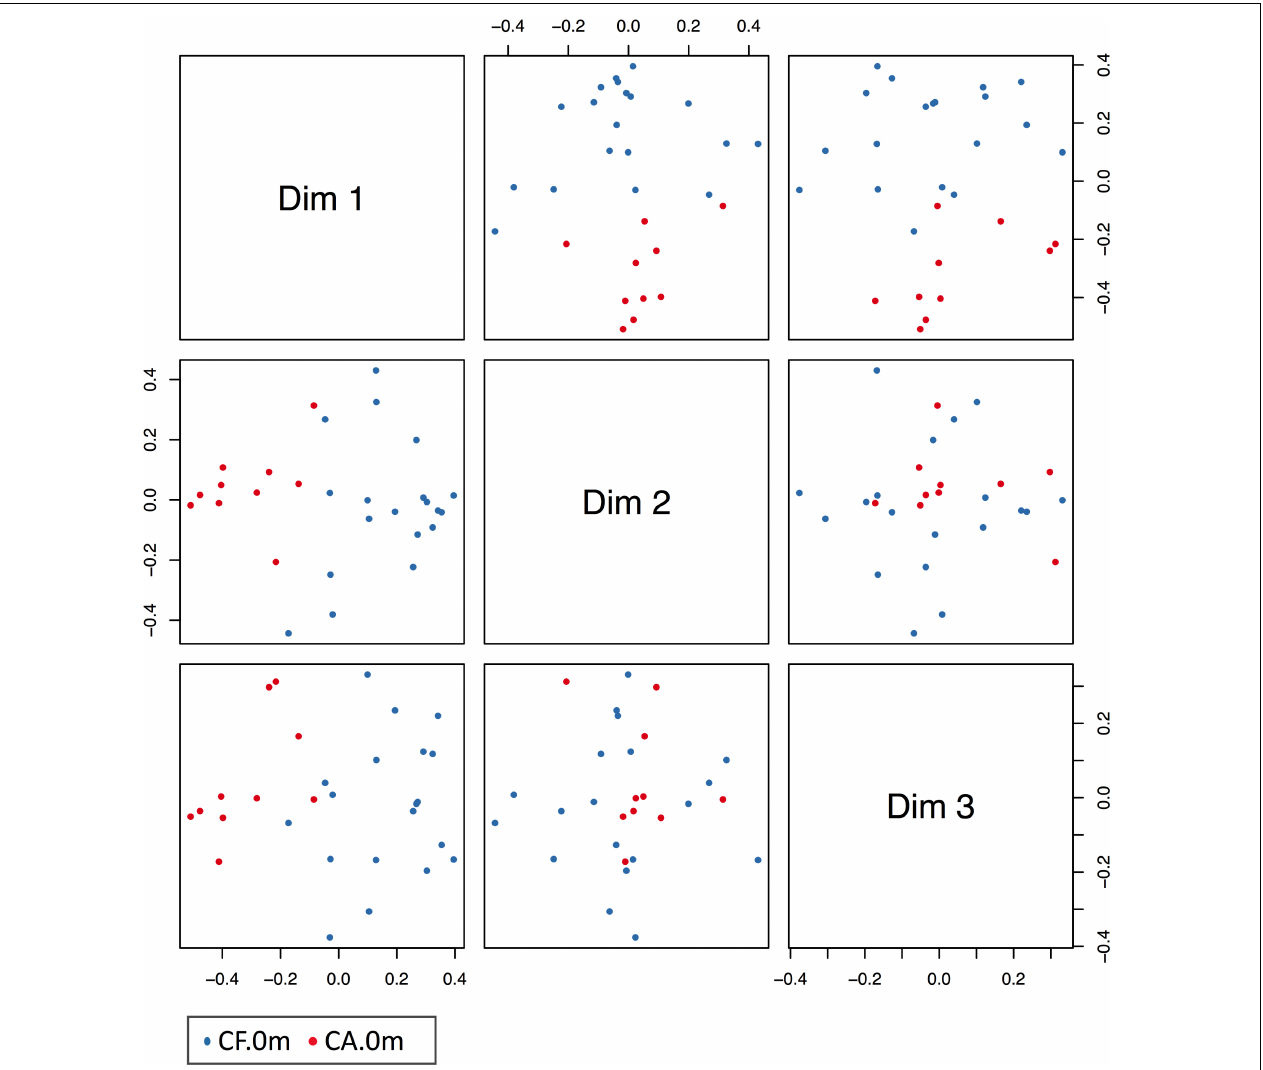
FIGURE 6 | MSD figure of the prediction model of caries onset. Blue dots and red dots indicate CF and CA samples, respectively. In the figure, CF, and CA samples were largely separated at different dims’